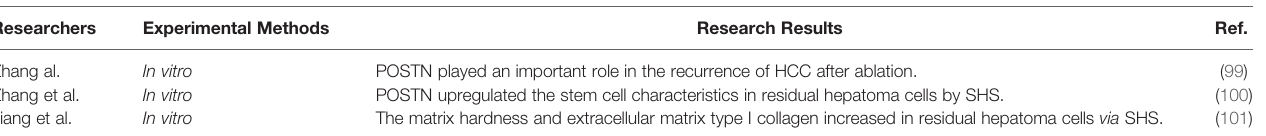
TABLE 4 | TME changes in recurrence after ablation of